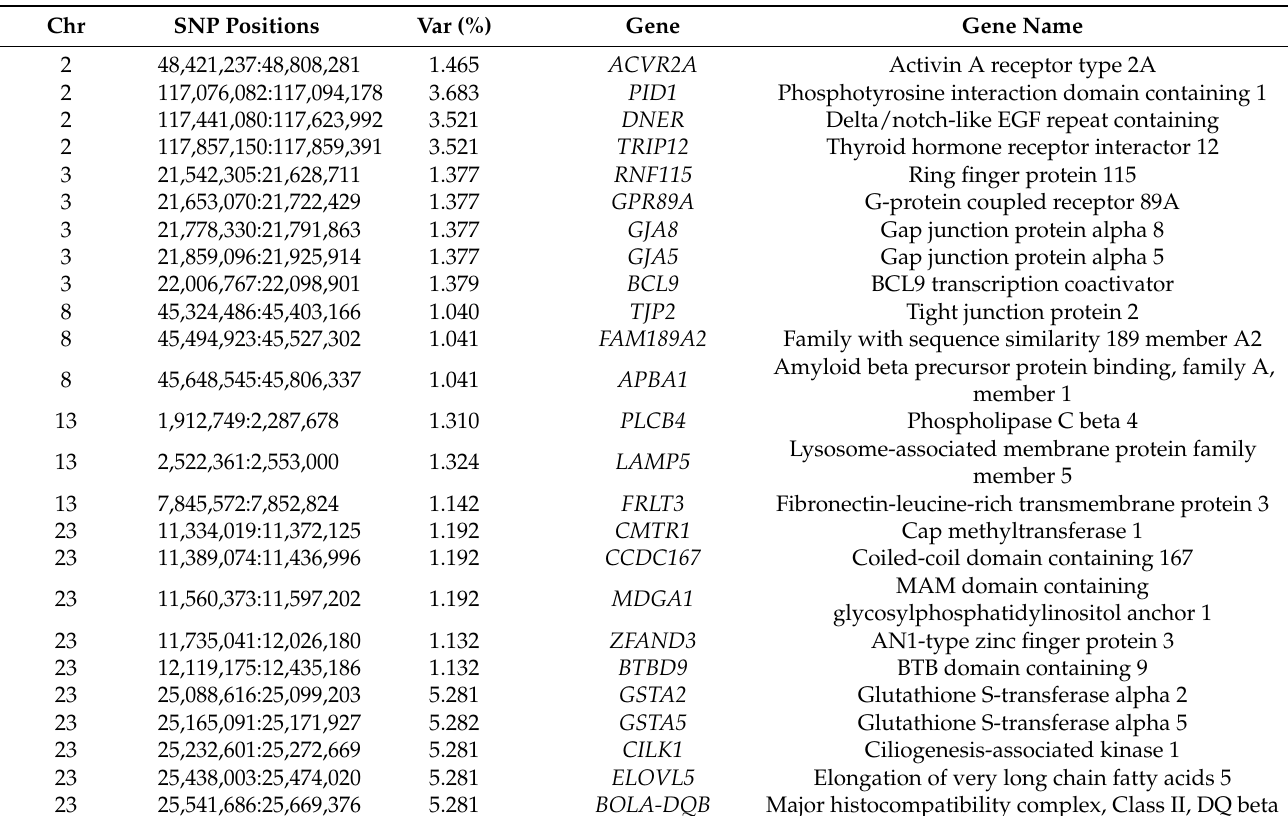
Table 3. Identification and description of genes located in windows associated with visual scores for precocity (PREC) that explained more than 1% of the additive genetic variance.